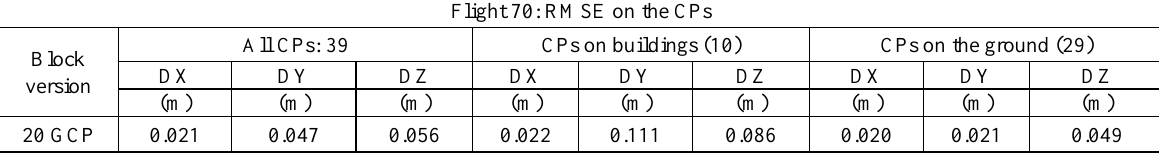
Table 6 - Flight 70: RMSE of total CPs, of CPs on buildings and on the